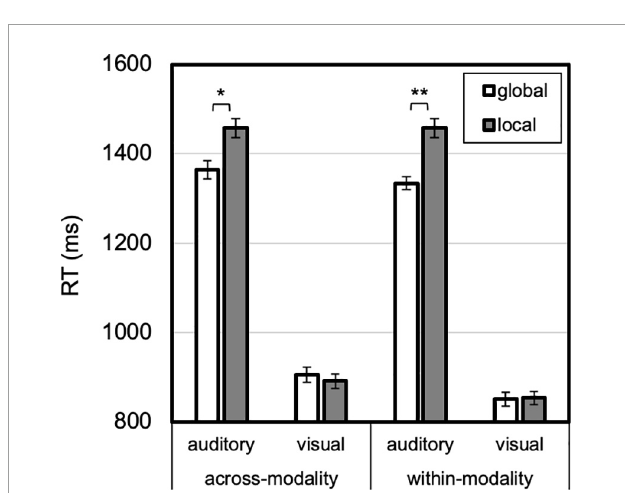
FIGURE6 Level by modality priming by modality. An auditory global (vs. local) advantage was larger after modality repeated than when modality